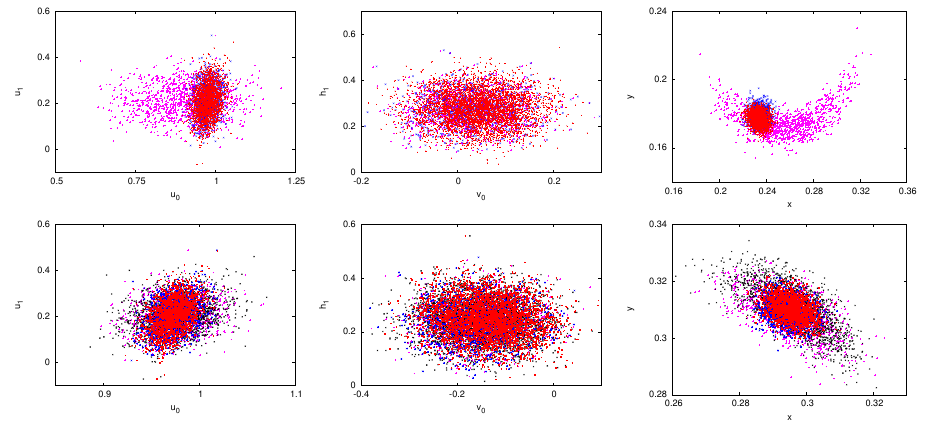
q (cid:113) (cid:113) = 6 S Σ S = Σ S = ζ ζ ζ